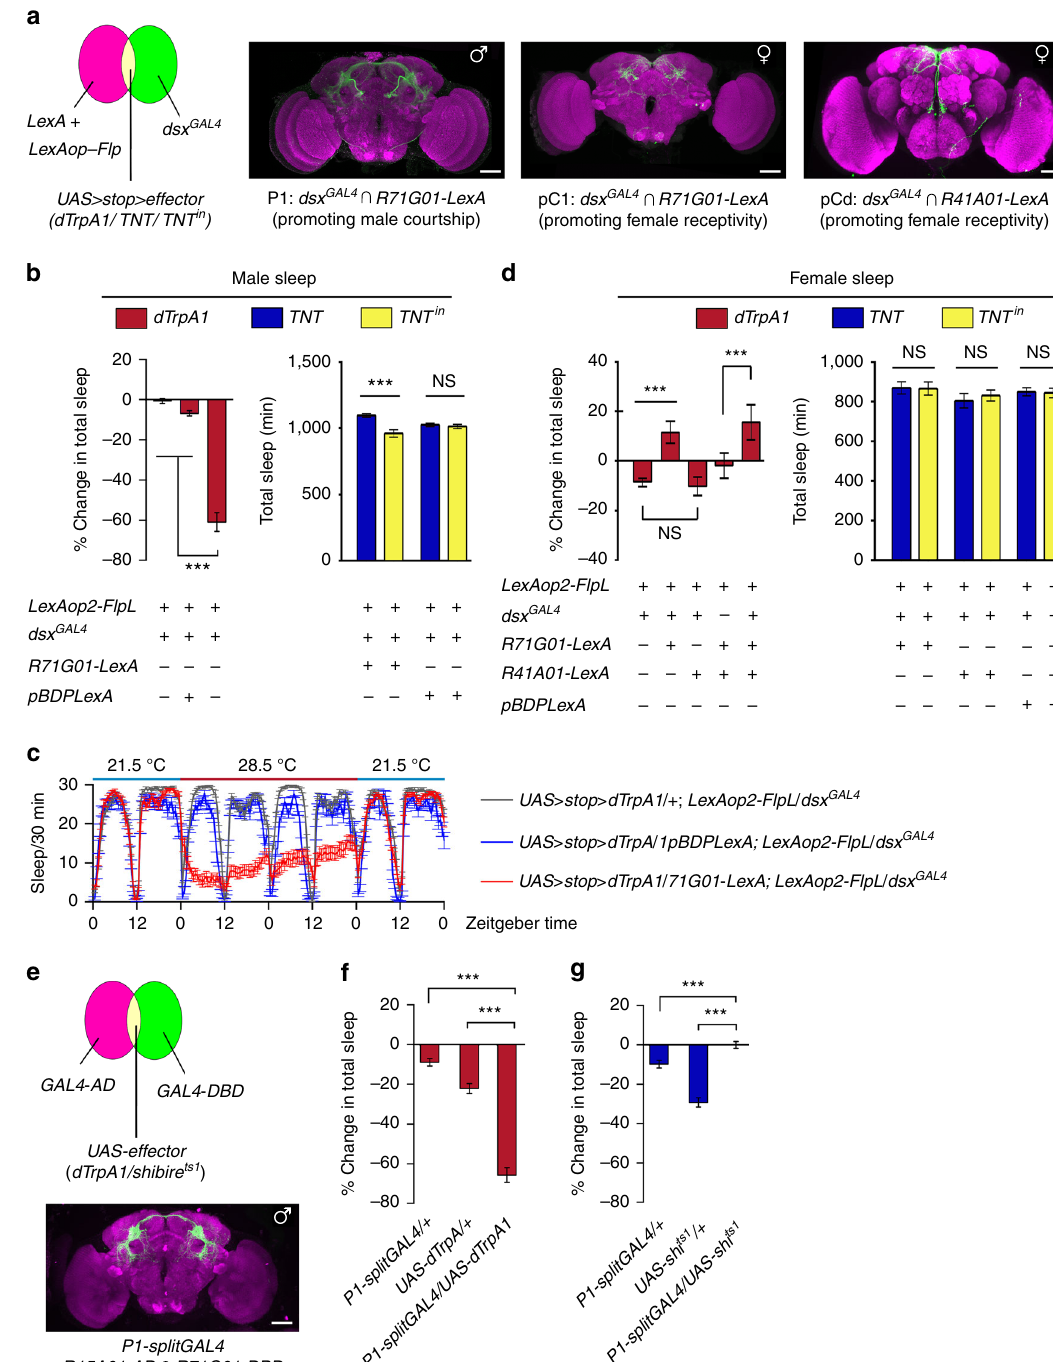
Fig. 2 Sex-promoting neurons regulate sleep. a Diagram of intersectional strategy to label and manipulate subsets of dsx neurons: P1 neurons in males promoting male courtship, pC1 and pCd neurons in females promoting female receptivity. b Activating P1 neurons suppresses total sleep ( n = 60), and inhibiting P1 neurons promotes total sleep in male fl ies. c Detailed sleep plot of activating P1 neurons (in red line , controls in blue and gray ) in male fl ies. d Activating pC1 but not pCd neurons promotes female sleep, but inhibiting pC1 or pCd neurons does not affect female sleep. e Another way of targeting P1 neurons using the splitGAL4 system. f Activation of P1 neurons inhibits male sleep. g Silencing P1 neurons slightly increases male sleep compared to controls. n = 24~32 for each. *** p < 0.001, unpaired t- test. NS , not signi fi cant. Error bars indicate SEM. Scale bars, 50 µ